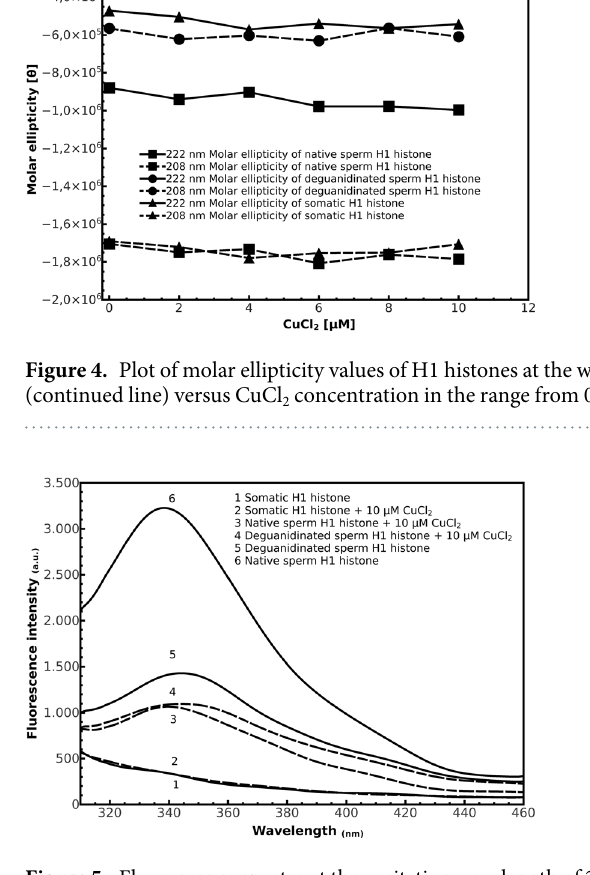
Figure 5. Fluorescence spectra at the excitation wavelength of 290 nm of H1 histones in absence (continued line) and presence of 10 μ M CuCl 2 (dashed